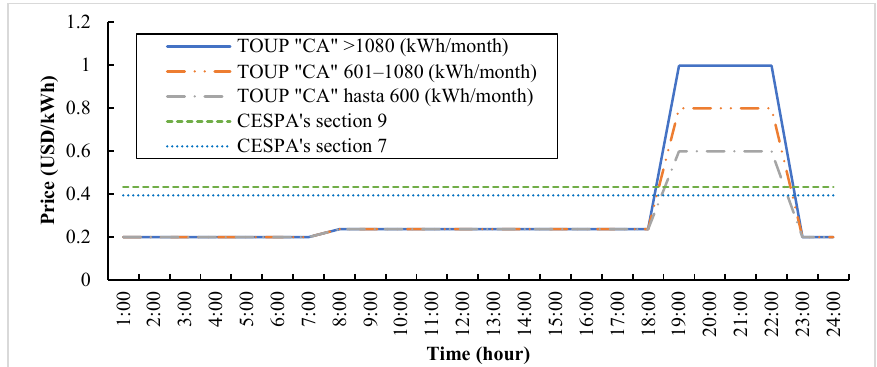
Figure 6. TOUP Commercial A option vs. sections of CESPA in February 2020 trends.